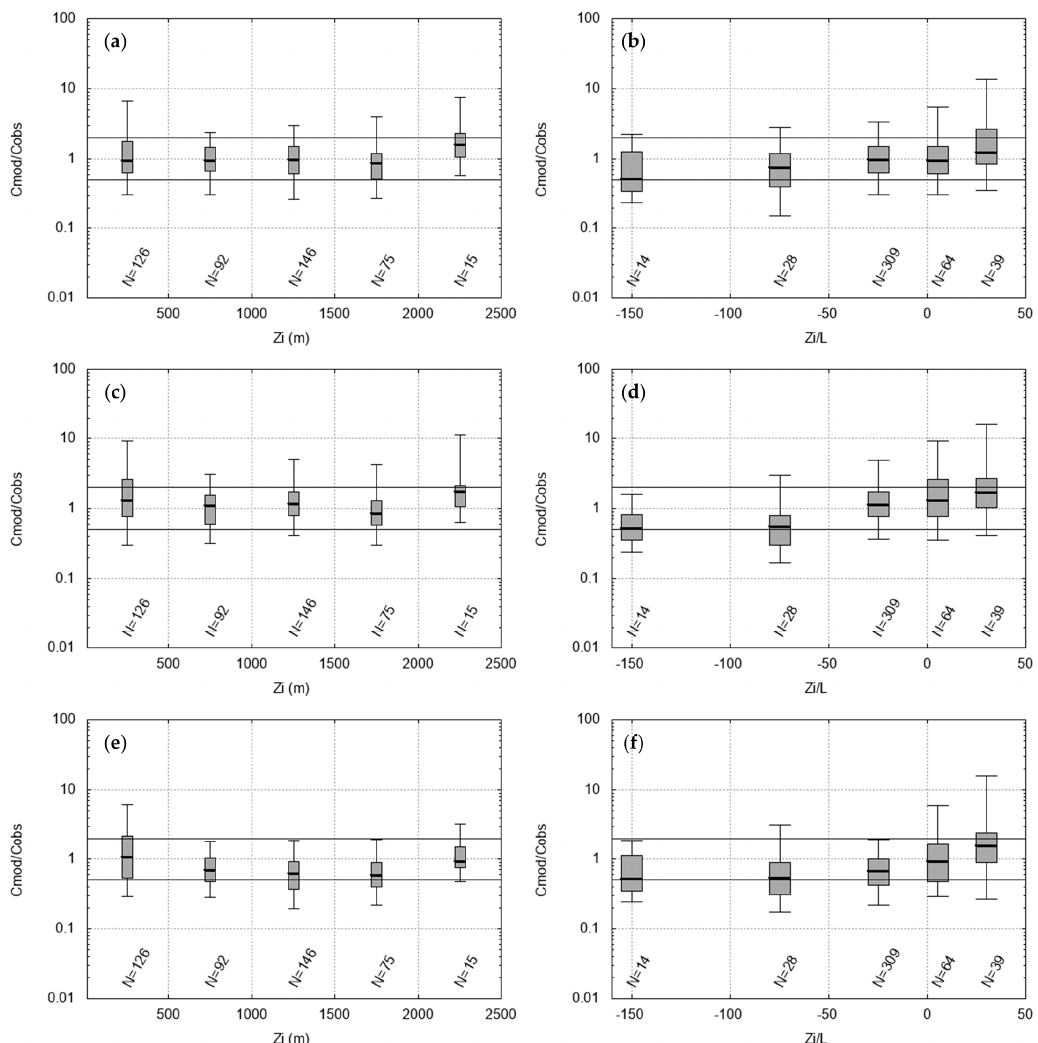
Figure 3. Residual box plots with respect to mixing height and ratio between mixing height and Monin Obukhov length for Indianapolis best-quality data: ( a ) WT plume rise, mixing height; ( b ) WT plume rise, ratio between mixing height and Monin Obukhov length; ( c ) JJ + RS plume rise, mixing height; ( d ) JJ + RS plume rise, ratio between mixing height and Monin Obukhov length; ( e ) JJ + JJ plume rise, mixing height; ( f ) JJ + JJ plume rise, ratio between mixing height and Monin Obukhov length.